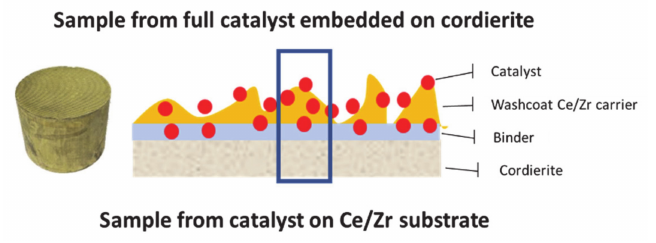
Figure 2. Configurations of the samples used on this study (full scale